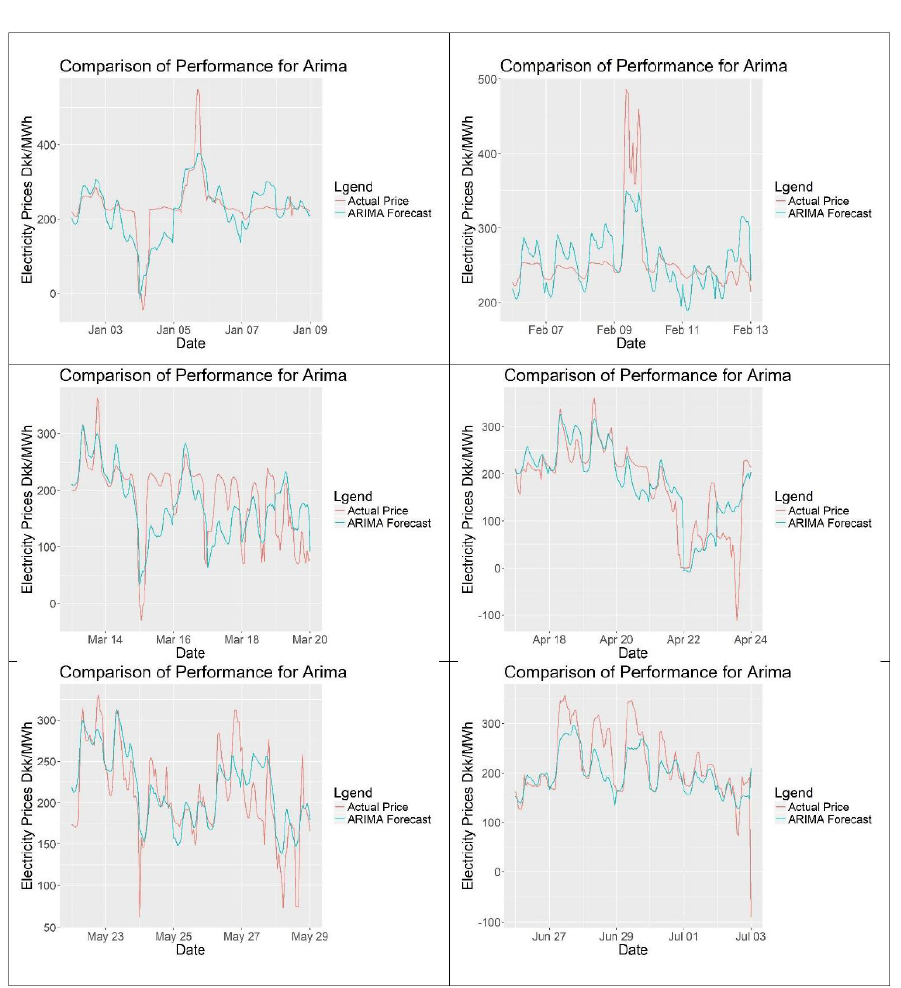
Energies 2019 , 12 , x FOR PEER REVIEW